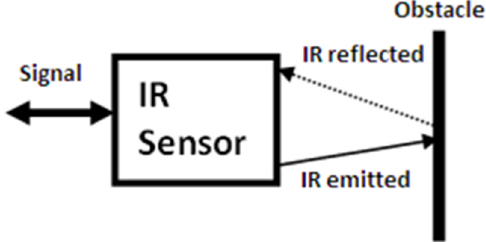
Figure 6. IR sensor working principle (adapted from Reference [38], with permission from the 2016 Research Trend).